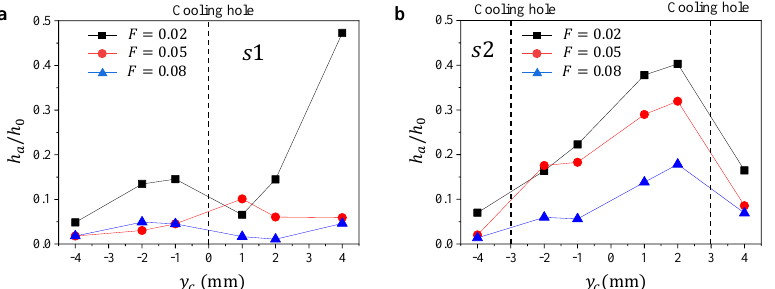
characteristics, compared with that generated by one single film cooling outflow.